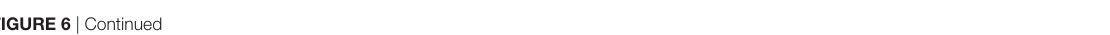
FigUre 6 | Continued Herpes simplex virus type 1 (HSV-1) infection exacerbated lung injury, induced endoplasmic reticulum stress, and downregulated stimulator of interferon genes (STING) protein expression in mice with bleomycin-induced lung fibrosis. (a) Representative image of mouse lung sections with hematoxylin and eosin staining. The microscopic appearance of diffuse alveolar damage (DAD) with hyaline membranes (box) was founded in the lungs from mice treated with Bleomycin and HSV-1. Original magnification: × 200. Scale bars represent 100 µm ( n = 10). (B) Immunohistochemistry analysis of HSV-1 particle deposition in mouse lung tissues ( n = 10). Solid black arrows are pointing to cells infected by HSV-1. Percentages of cells infected by HSV-1 were quantified. Original magnification: × 200, scale bars